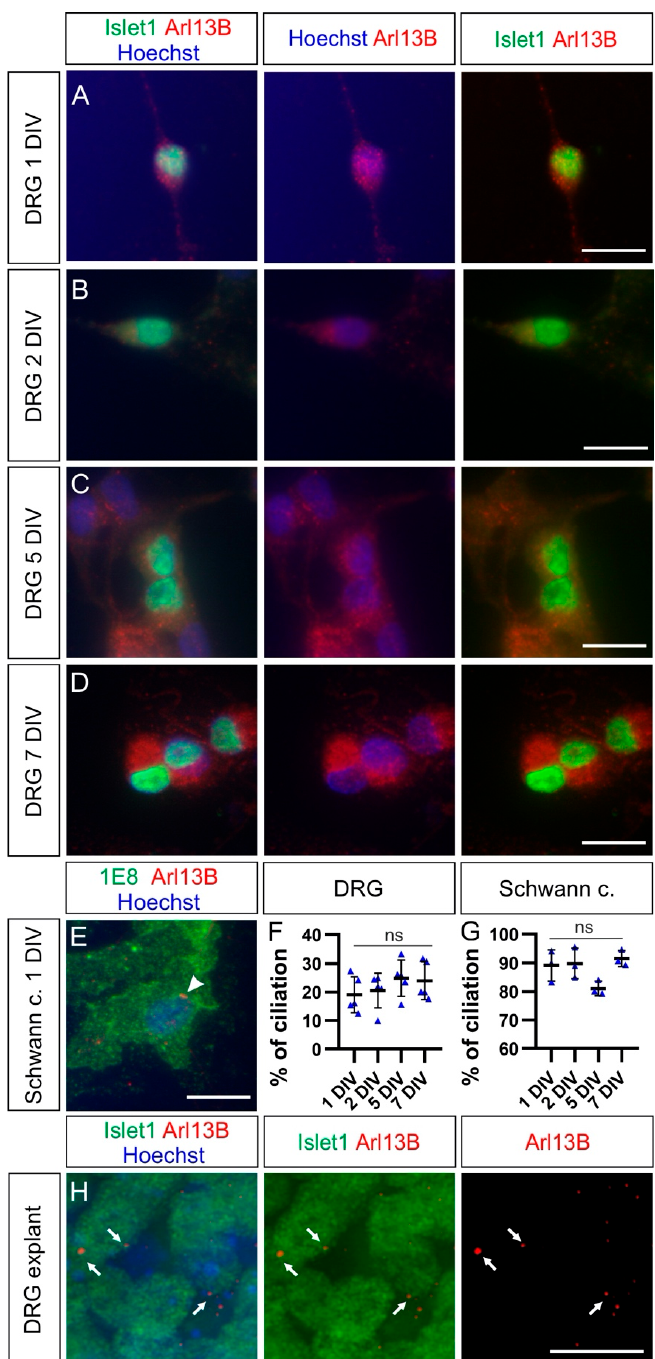
Figure 6. DRG neurons bear a primary cilium in explants but not in dissociated cultures. ( A – D ) Dissociated DRG neurons cultured for 1, 2, 5, or 7 days in vitro (DIV) were stained for Islet1 (green) together with Arl13B (red), revealing primary cilia, and counterstained with Hoechst (blue) to visualization nuclei. No clear Arl13B-positive ciliary structures could be seen on these cells. ( E ) Most Schwann cells possessed a primary cilium in dissociated cell culture (white arrowhead). ( F , G ) Quantification of the average percentage of ciliation in dissociated cultures of DRG neurons and Schwann cells up to one week of culture. Error bars represent standard deviations. Kruskal–Wallis test with Dunn’s multiple-comparisons test ( F ) and one-way ANOVA with Dunn’s multiple-comparisons test ( G ). p ≥ 0.05, ns. ( H ) Islet1-positive DRG neurons in DRG explants possessed a primary cilium (red) after 1 DIV (white arrows). Schwann c., Schwann cells. Scale bars: 15 µ